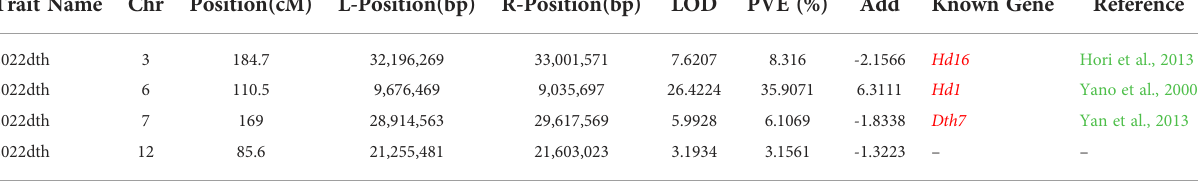
TABLE 2 RIL QTL mapping result by